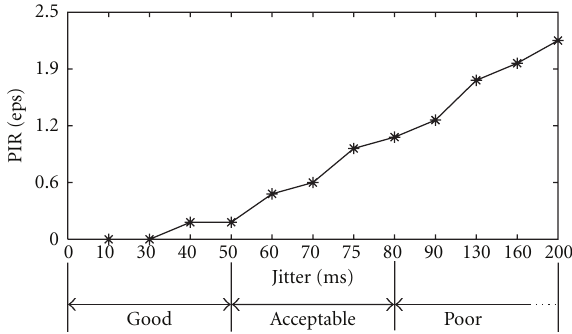
Figure 7: Jitter GAP ranges for QCIF resolution under